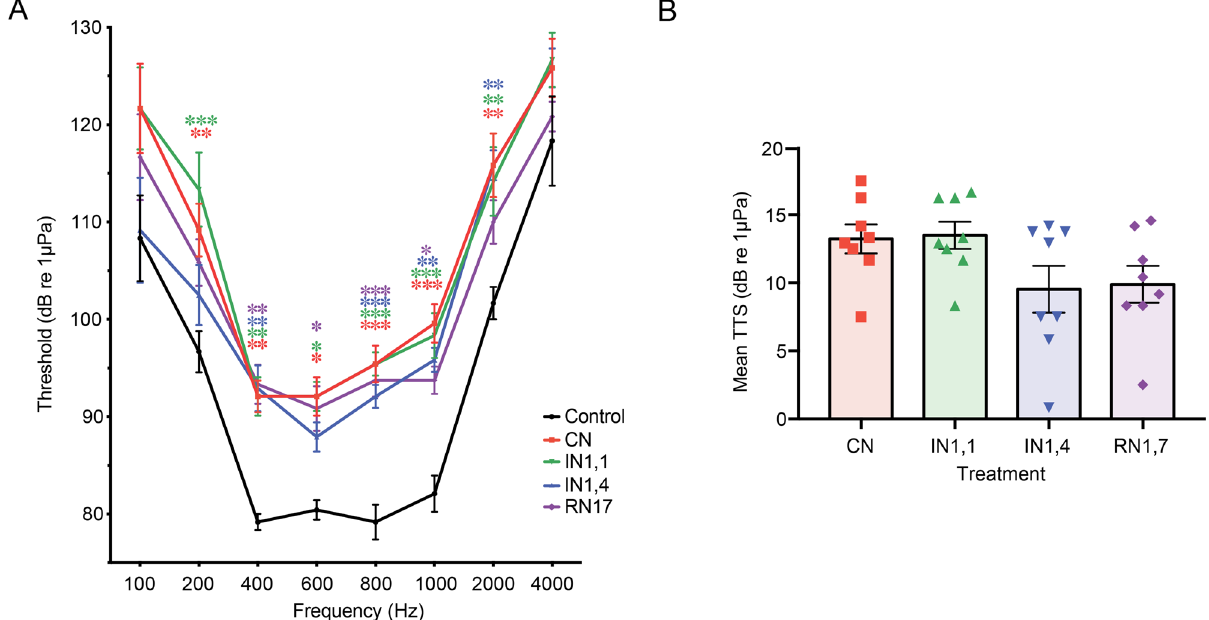
Figure 3. ( A ) Mean auditory thresholds ± Standard Error of the Mean (SEM) of zebrafish after 24 h of either silent lab conditions (control, c. 105 dB re 1 µPa) or white noise of different temporal patterns. Noise induced significant changes in the auditory thresholds (F 4,25 = 24.710, P < 0.0001) and specific differences between groups at each frequency are indicated based on post hoc tests (*P < 0.05, **P < 0.01, ***P < 0.001). ( B ) Comparison of overall mean Temporary Threshold Shifts (TTS, averaged across frequencies) ± SEM after different noise treatments. Noise exposure induced TTS in all groups but no significant differences were found between them (F 3,28 = 2.560, P > 0.05). (CN: continuous noise; IN1,1: intermittent noise with 1 s pulses and 1 s silent; IN1,4: intermittent noise with 1 s pulses and 4 s silent; RN1,7: intermitted random noise with 1 s pulses and 1–7 s silent